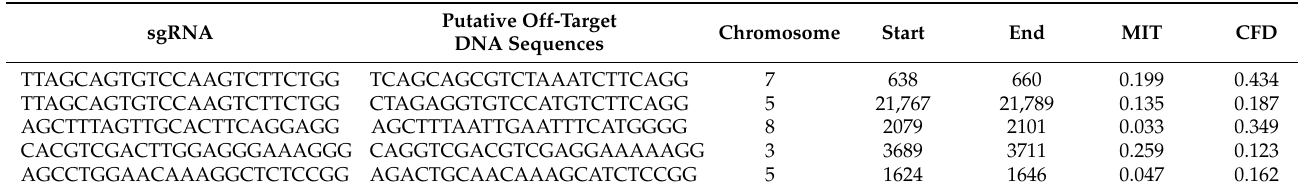
Table 1. Examples of sgRNA, DNA, the coordinates of DNA, MIT and CFD scores. Putative Off-Target sgRNA DNA Sequences